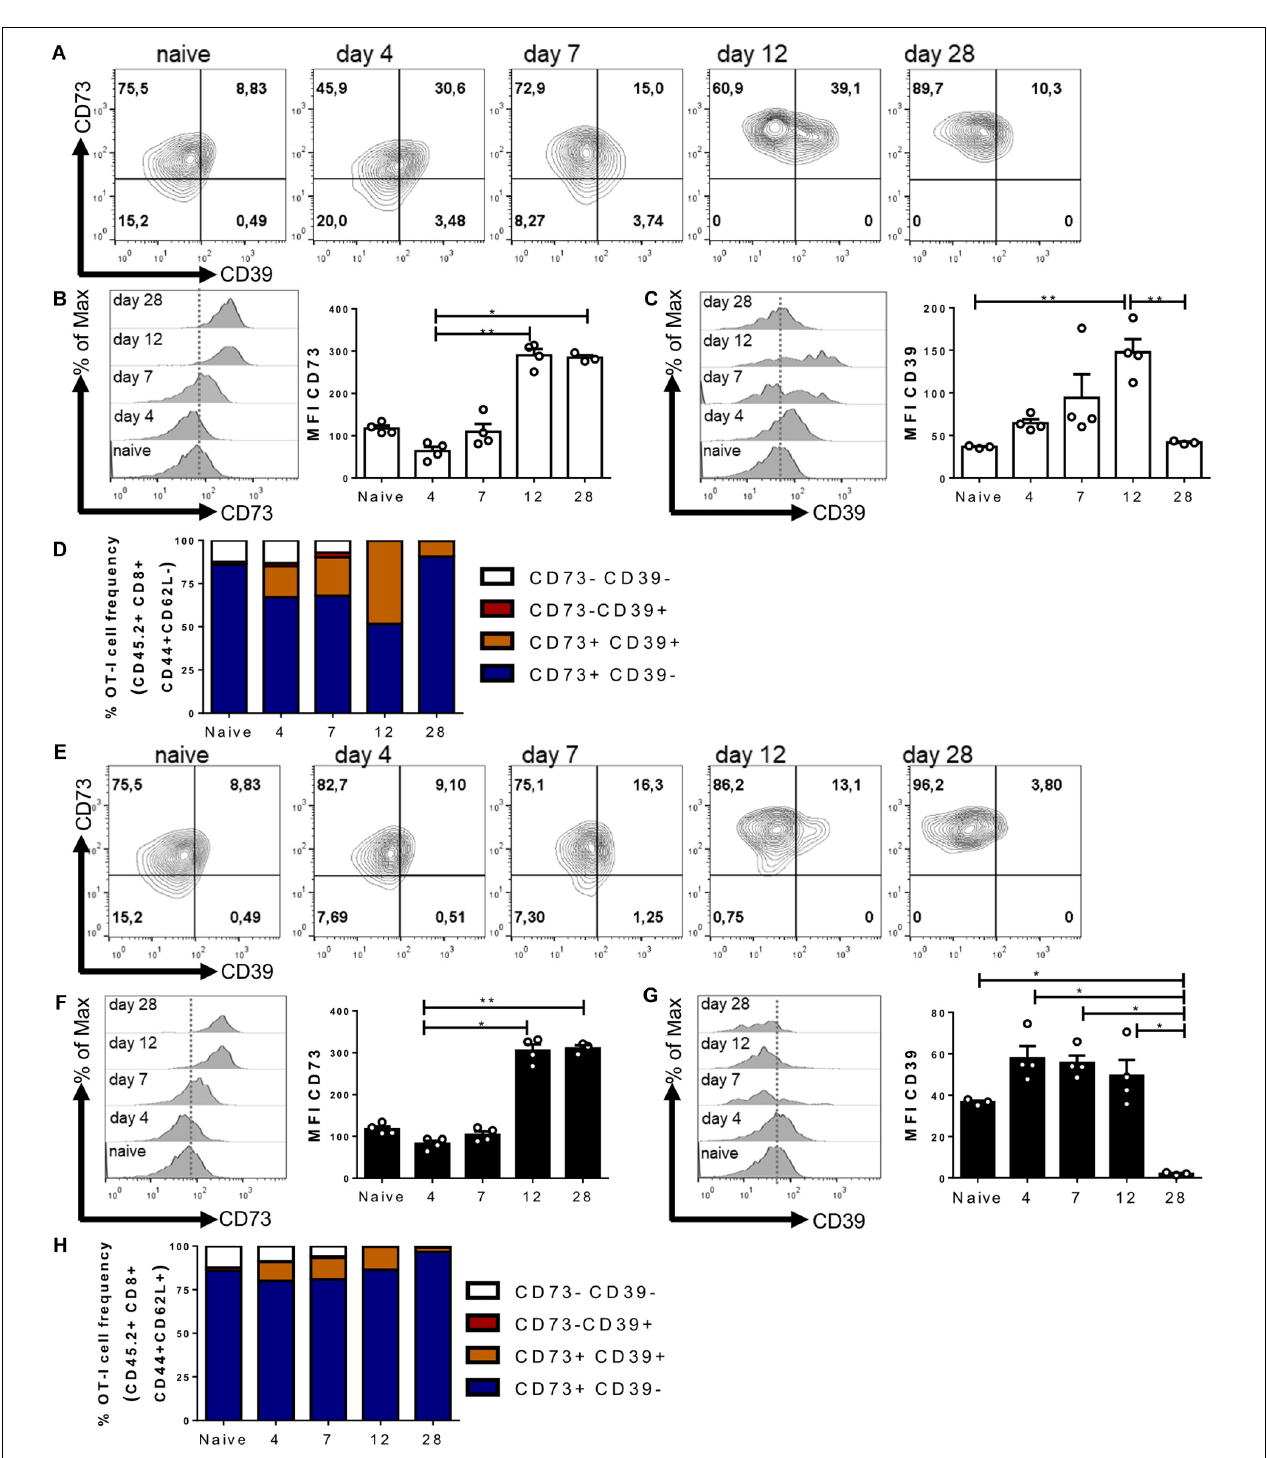
FIGURE 2 | CD39 and CD73 ectonucleotidases are upregulated during an in vivo immune response. Naive OT-I cells (10 6 cells) were injected into CD45.1+ recipient mice. 24 h later, the recipient mice were immunized i.p with OVA protein (500 µ g) + LPS (25 µ g). Transferred cells were analyzed in blood samples on days 4, 7, 12, 21, and 28 after the immunization. (A–D) CD39 and CD73 expression was analyzed in the effector memory precursors (CD45.2+/CD8+/CD44+/CD62L–) or central memory precursors (CD45.2+/CD8+/CD44+/CD62L+) (E–H) at different time points. n = 4, Kruskal–Wallis Test, * p < 0.05; ** p < 0.01.